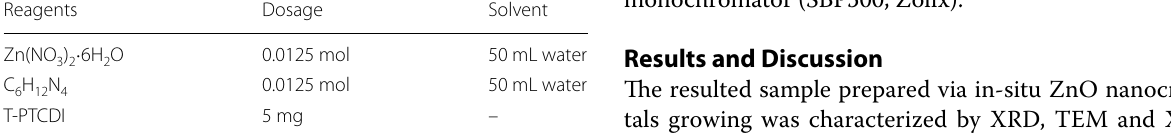
Table 1 Chemical reagents for synthesis of T-PTCDI/ZnO nanorod composite Reagents